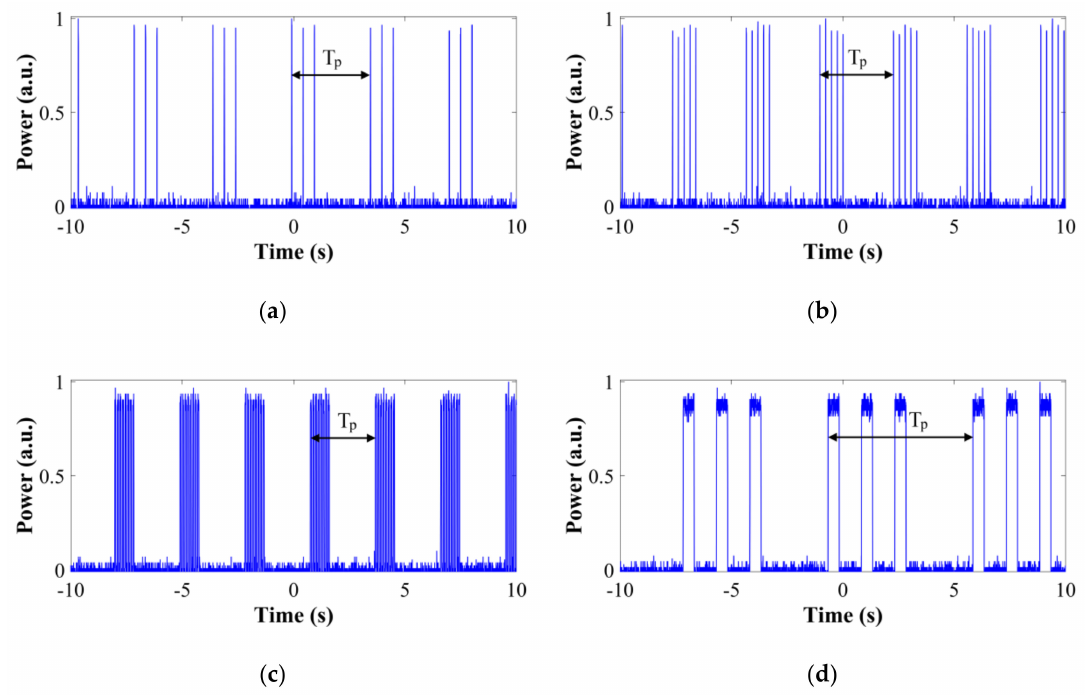
Figure 4. Train of periodic non-conventional (asynchronous) pulses: packets of ( a ) three pulses, ( b ) five pulses, ( c ) eight pulses and ( d ) three very long